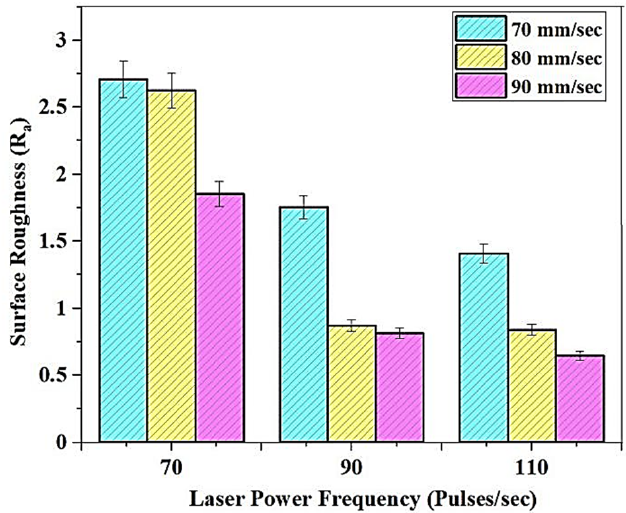
Figure 6. Variation of Surface Roughness with change in print parameters.